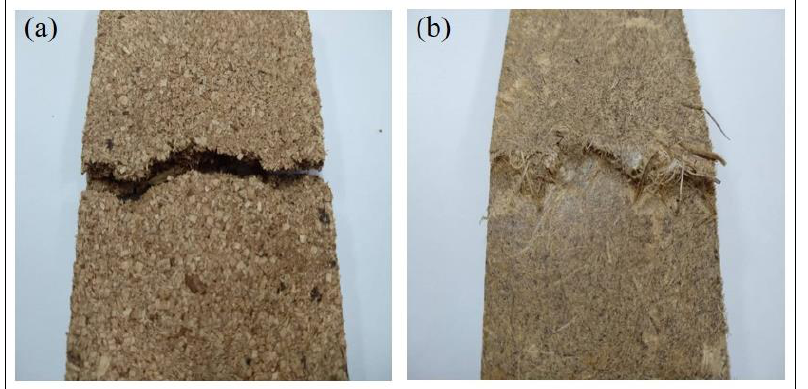
Figure 11. Examples of specimens after the flexural test. ( a ) Composite panel made from 100 SMS: 0 EFB and ( b ) composite panel made from 0 SMS: 100 EFB.